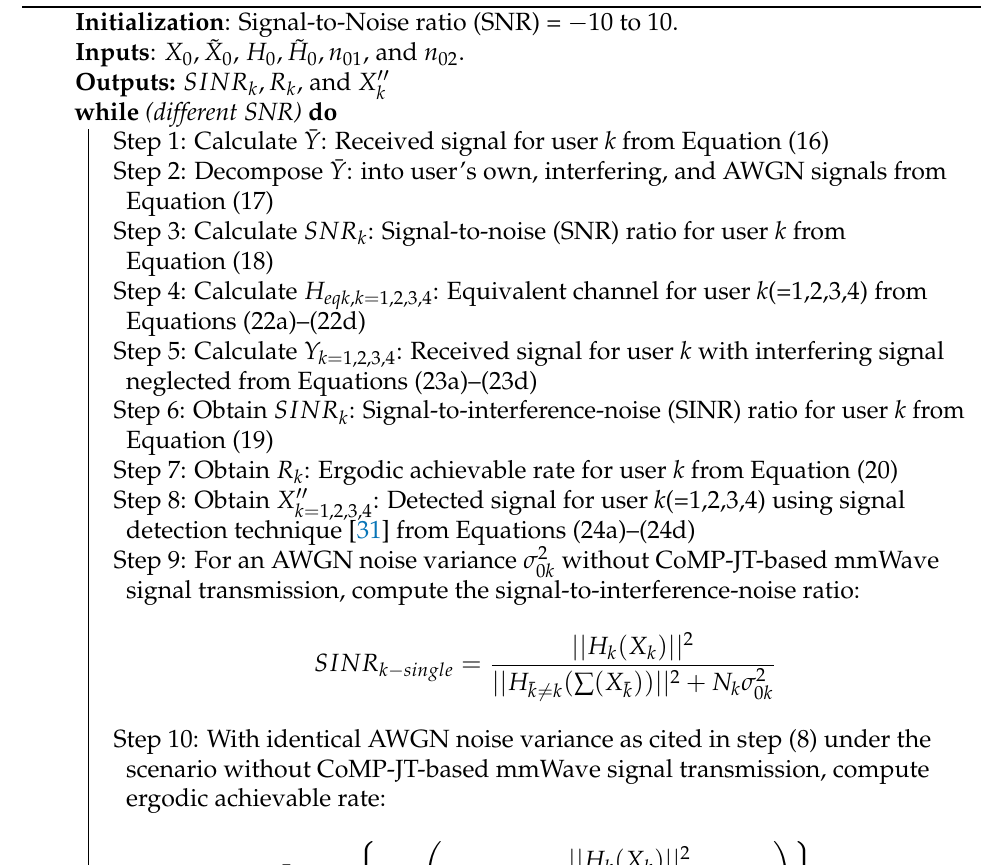
Algorithm 1: For user k without HPA